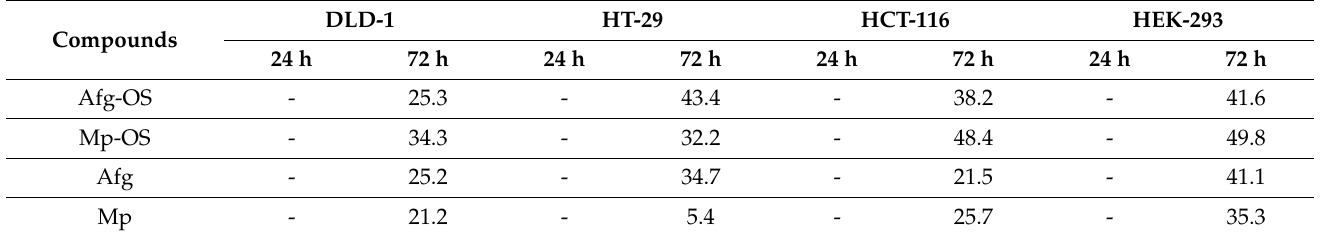
Table 5. Cytotoxic and antiproliferative activity of the poly- and oligosaccharides from A. flabelliformis and M. pacificus against various types of tumor and normal human